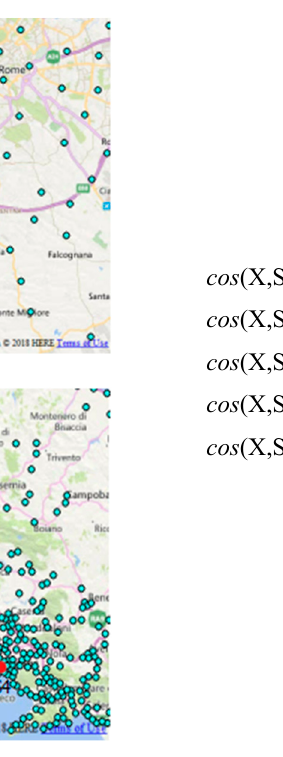
Figure 10. Example about similarity of airports. The top five similarities with location X are reported: top similarity values are even lower than in Figure 9. It is worth observing that the fourth highest similarity is related to another airport in another city.